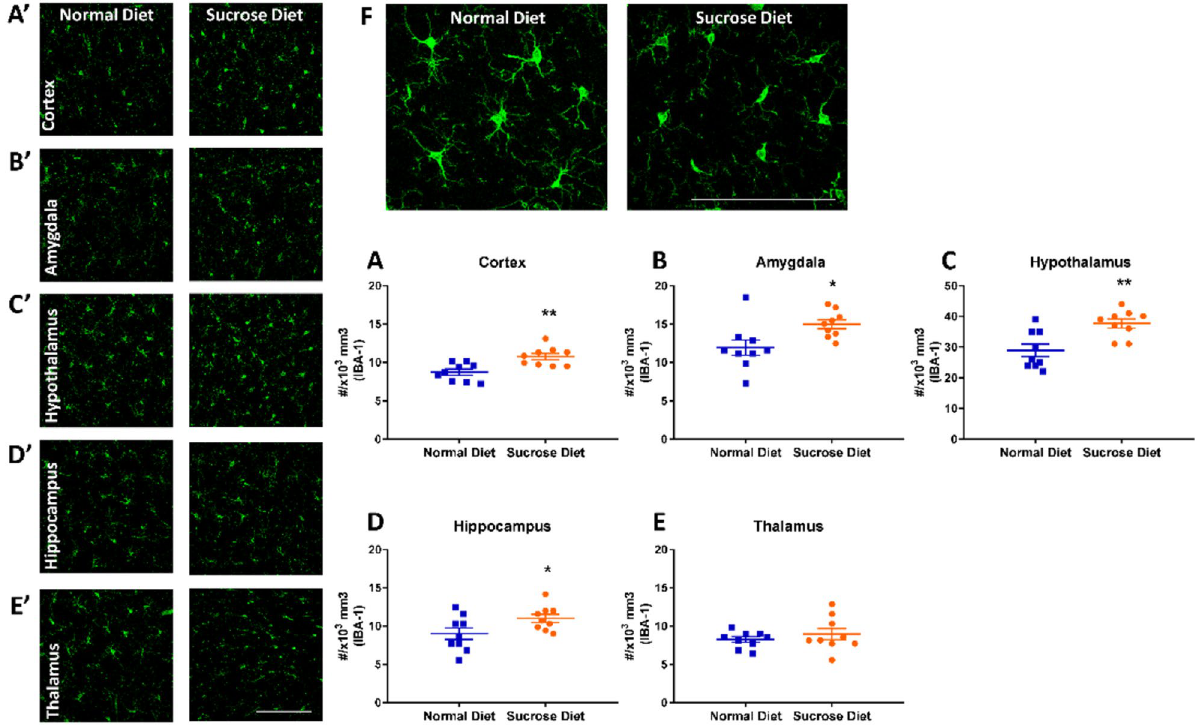
Figure 4. Quantification of microglia following 12-weeks binge sucrose intake in rats. Immunohistological analysis revealed elevated microglial cell count in the ( A ) motor cortex, ( B ) amygdala, ( C ) hypothalamus and ( D ) hippocampus in the sucrose diet rats as stained with IBA-1 (green). ( A’ – D’ ) shows representative staining in each of these regions in the normal diet (left panel) and sucrose diet (right panel) groups, scale bar = 100 µm. The density of microglia did not differ in the thalamus ( E and E’ ), scale bar = 100 µm. All values are presented as mean number of IBA-1 positive cells ± SEM normalized to volume of the brain region imaged (10 3 mm 3 ) analysed with Student’s two-tailed t-test. *p < 0.05, **p < 0.01 compared to controls. All values presented are from n = 9 per